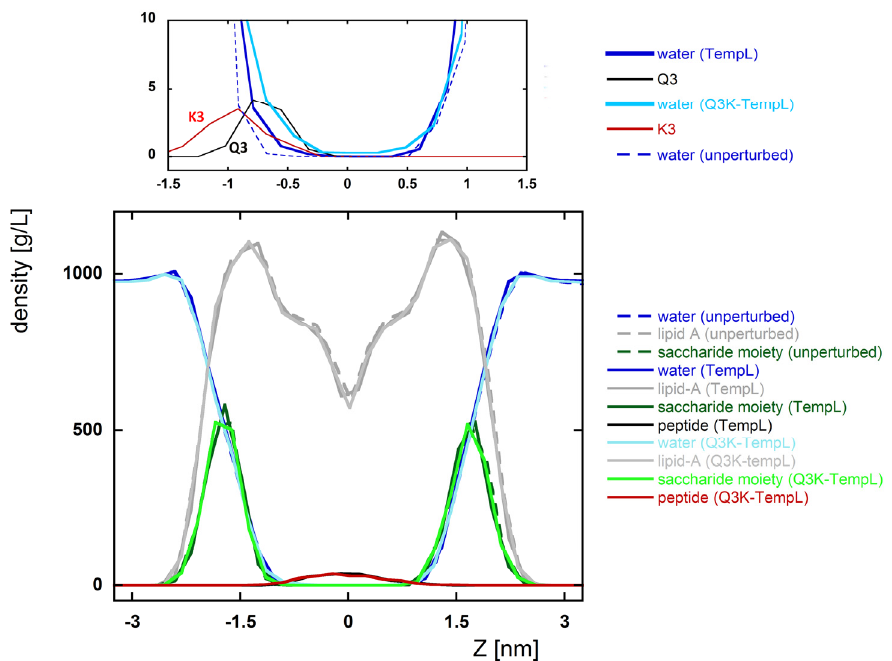
Figure 4. Density profile along the axis perpendicular to the bilayer plane (Z axis) calculated on the structures in the absolute minimum of the PMF profile. The reported profiles refer to water (broken blue, solid blue and solid cyan for unperturbed bilayer, with TempL and with Q3K-TempL, respectively), lipid-A (broken gray, solid gray and solid light gray for unperturbed bilayer, with TempL and with Q3K-TempL, respectively), the saccharide moiety of lipid-A (broken dark green, solid dark green and solid light green for unperturbed bilayer, with TempL and with Q3K-TempL, respectively). The black and red lines refer respectively to the whole TempL and Q3K-TempL peptides (below) and to the Q3 and K3 side chain residues (above). To highlight the effects of the mutated residue, the graph above reports a magnification of the central region of the density profile.